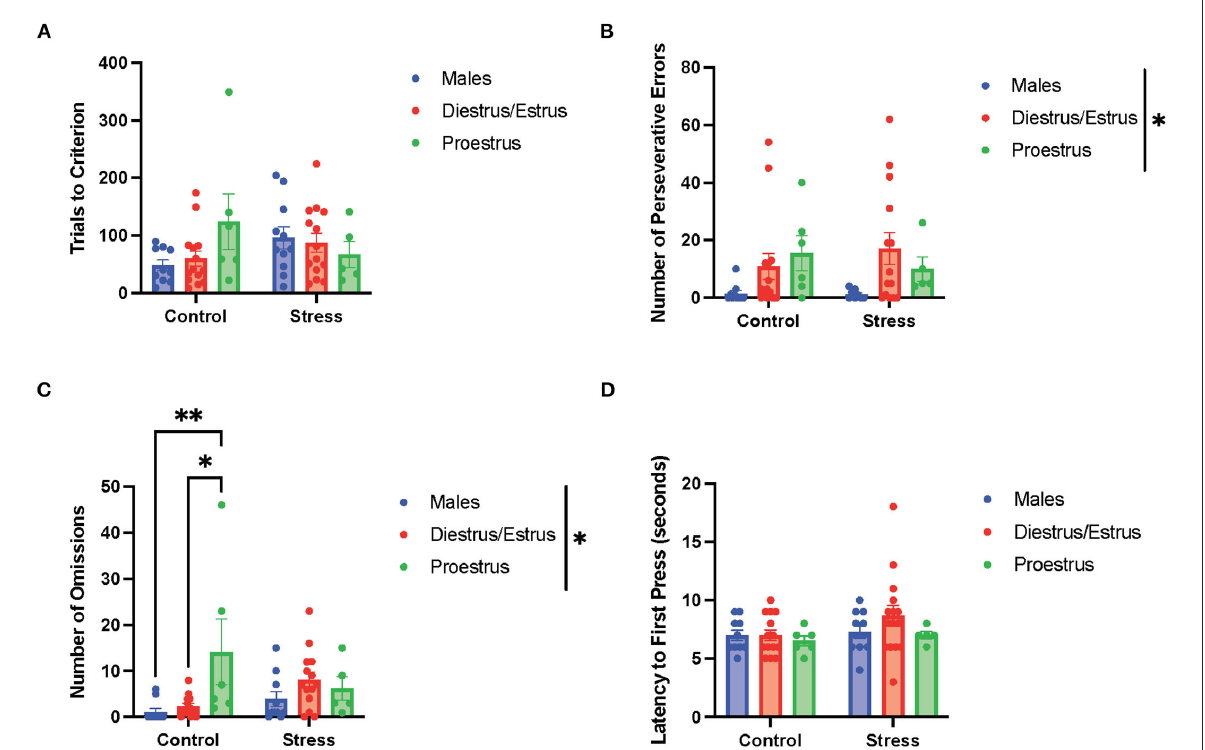
FIGURE7 Gonadal hormone status and acute stress impacted performance in the light discrimination task. (A) Gonadal hormone status and acute stress did not affect trials to criterion. (B) There was a main effect of gonadal hormone status on the number of perseverative errors. Although the female rats appear to have higher perseverative errors than the male rats in general, the post-hoc tests did not indicate that any particular group was significantly different from another. (C) There was a main effect of gonadal hormone status and an interaction between gonadal hormone status and stress on the number of omissions in the light discrimination task. Moreover, the post-hoc tests revealed that the control proestrus female rats had a higher number of omissions than the control male and control diestrus/estrus female rats. (D) Gonadal hormone status and acute stress did not affect the latency to first press. Two-way ANOVAs followed by Tukey post-hoc tests were conducted to examine the relationship between stress and gonadal hormone status, and the interaction between the two variables on the measurements of light discrimination task performance for the male ( n = 21: control = 11, and stress = 10) and female ( n = 40, control diestrus/estrus = 14, control proestrus = 6, stress diestrus/estrus = 14, and stress proestrus = 6). Error bars are plotted as mean ± SEM. * p < 0.05 and ** p < 0.01.